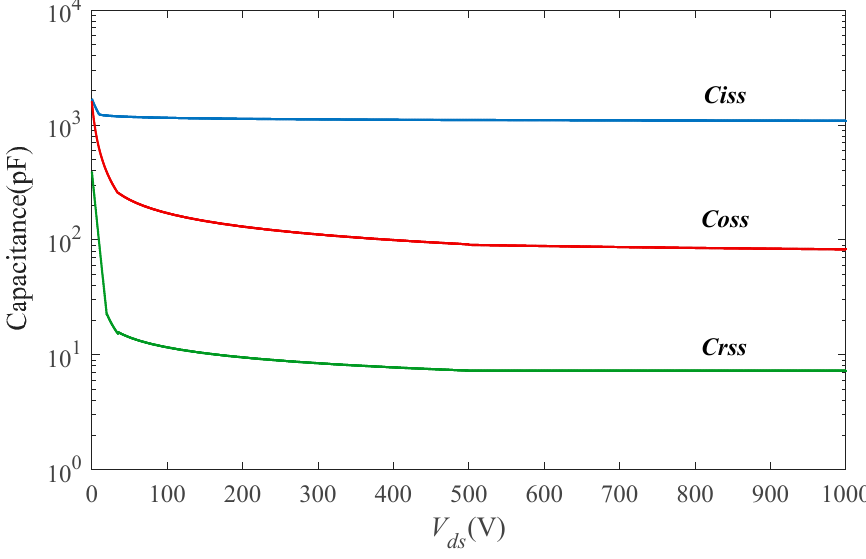
Figure 6. Parasitic capacitances in relationship with the drain-source voltage.